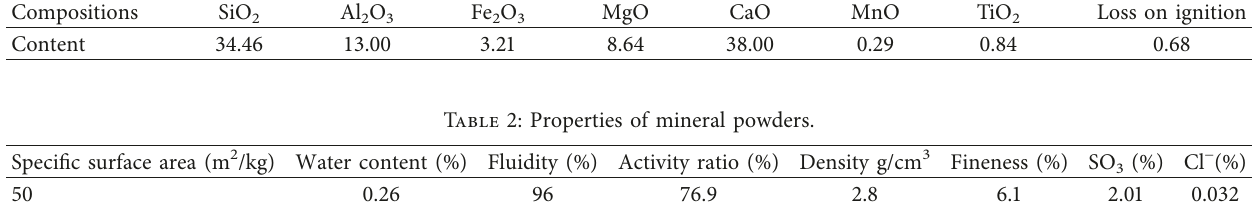
Table 1: Chemical composition of contents of blast furnace slag ( w